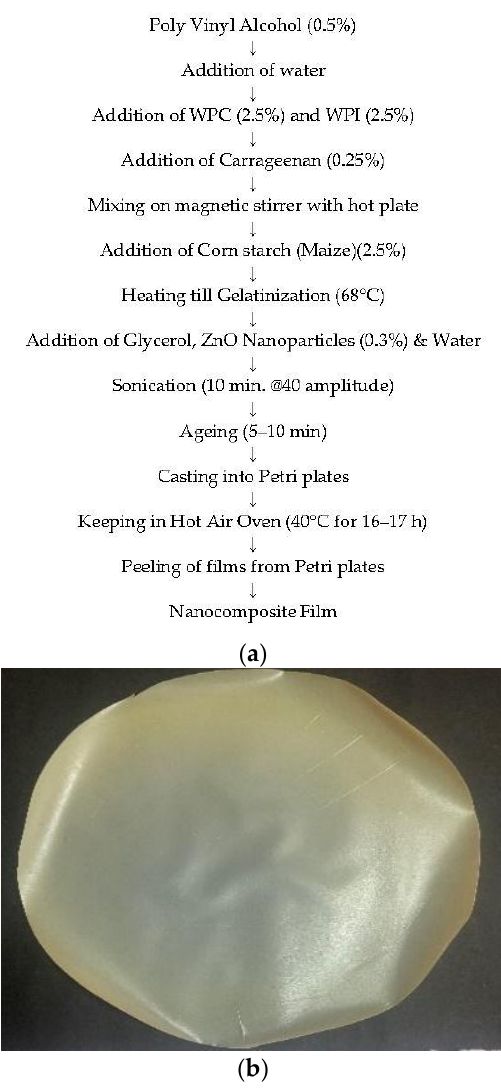
Figure 1. ( a ): Flow diagram for preparation of optimized nanocomposite film; ( b ): Corn starch (Maize) + WPC & WPI + PVA + carrageenan + glycerol + ZnO (active film).